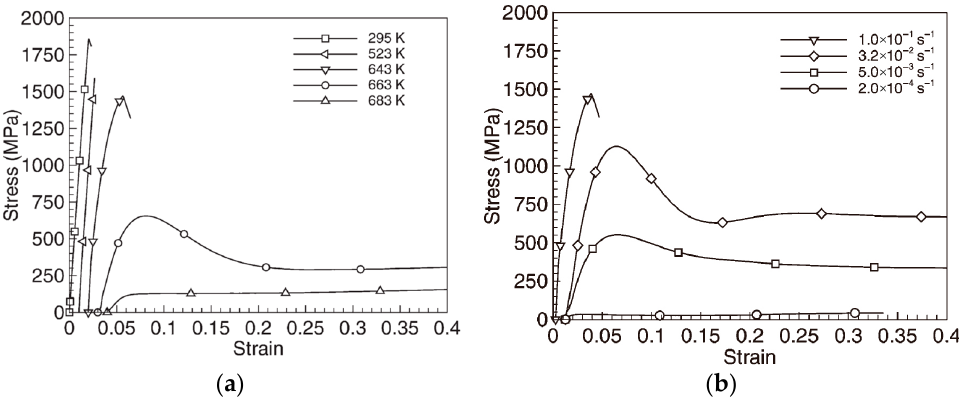
Figure 11. Compressive stress – strain curves of Zr-MG at ( a ) different temperatures and ( b ) different strain rates [21].